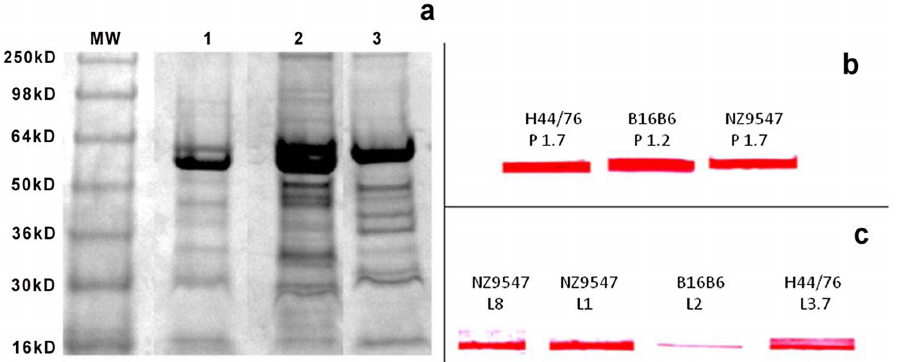
Figure 4. Analysis of the major surface antigens in the vaccine NOMV. SDS-PAGE gel (10%) of NOMV obtained from each of the three strains are shown in Fig. 4a. Comassie Blue stained gel showing NOMV from H44/76 in lane 1, NOMV from B16B6in lane 2 and NOMV from NZ9547 in lane 3. In Fig. 4b is shown the results of the western blot indicating the presence of PorAs in the NOMV from the three strains, and in Fig. 4c is shown the results of the Western blots indicating the presence of LOS in the NOMV from the three